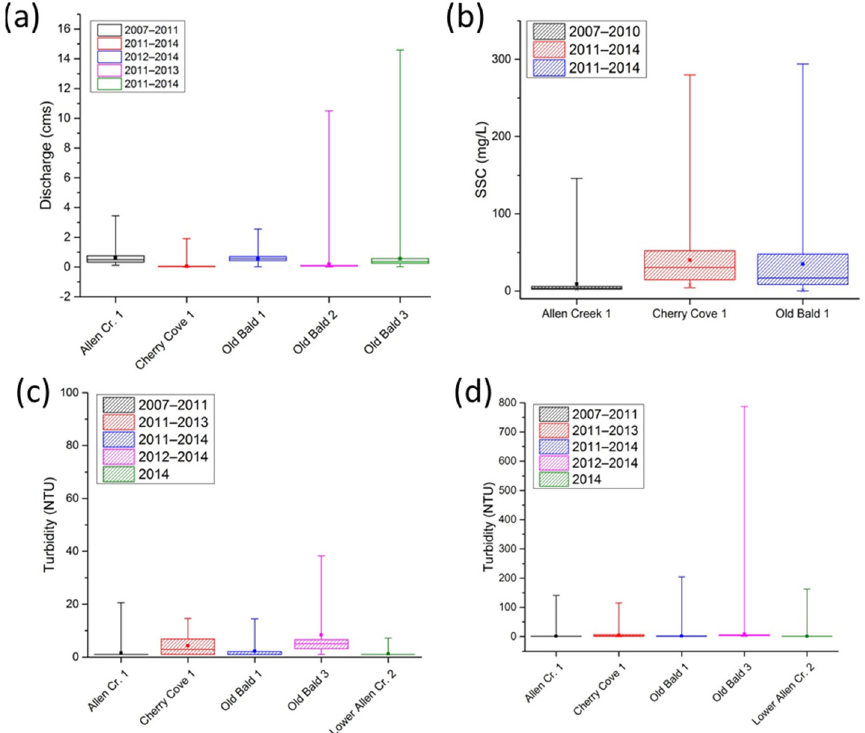
Figure 2. Between site comparison of measured flow (discharge) ( a ); suspended sediment concentration ( b ); and turbidity ( c , d ). Box represents 25%–75% frequency interval, whereas whiskers repent maximum and minimum values for a, b, c. The 1%–99% range is shown by the whiskers in plot c. Discharge values for lower Allen Creek #2 site are currently